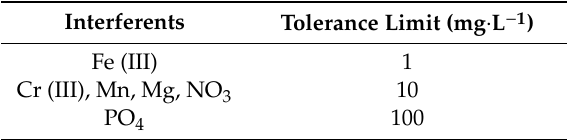
Table 3. E ff ect of foreign species on the determination of Cr (VI) (1 mg · L − 1